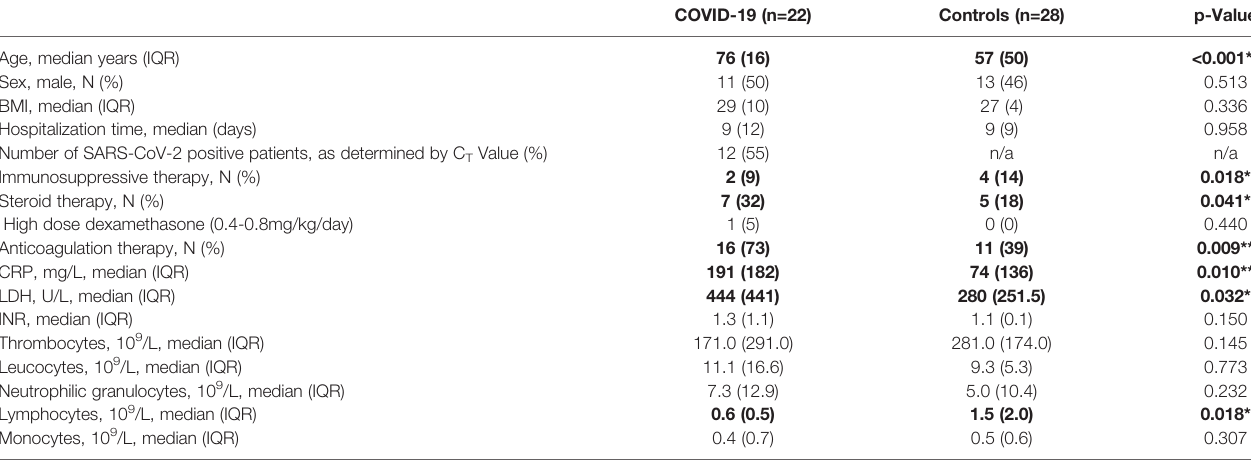
TABLE 1 | Clinical and Serological Characteristics of COVID-19 Patients versus